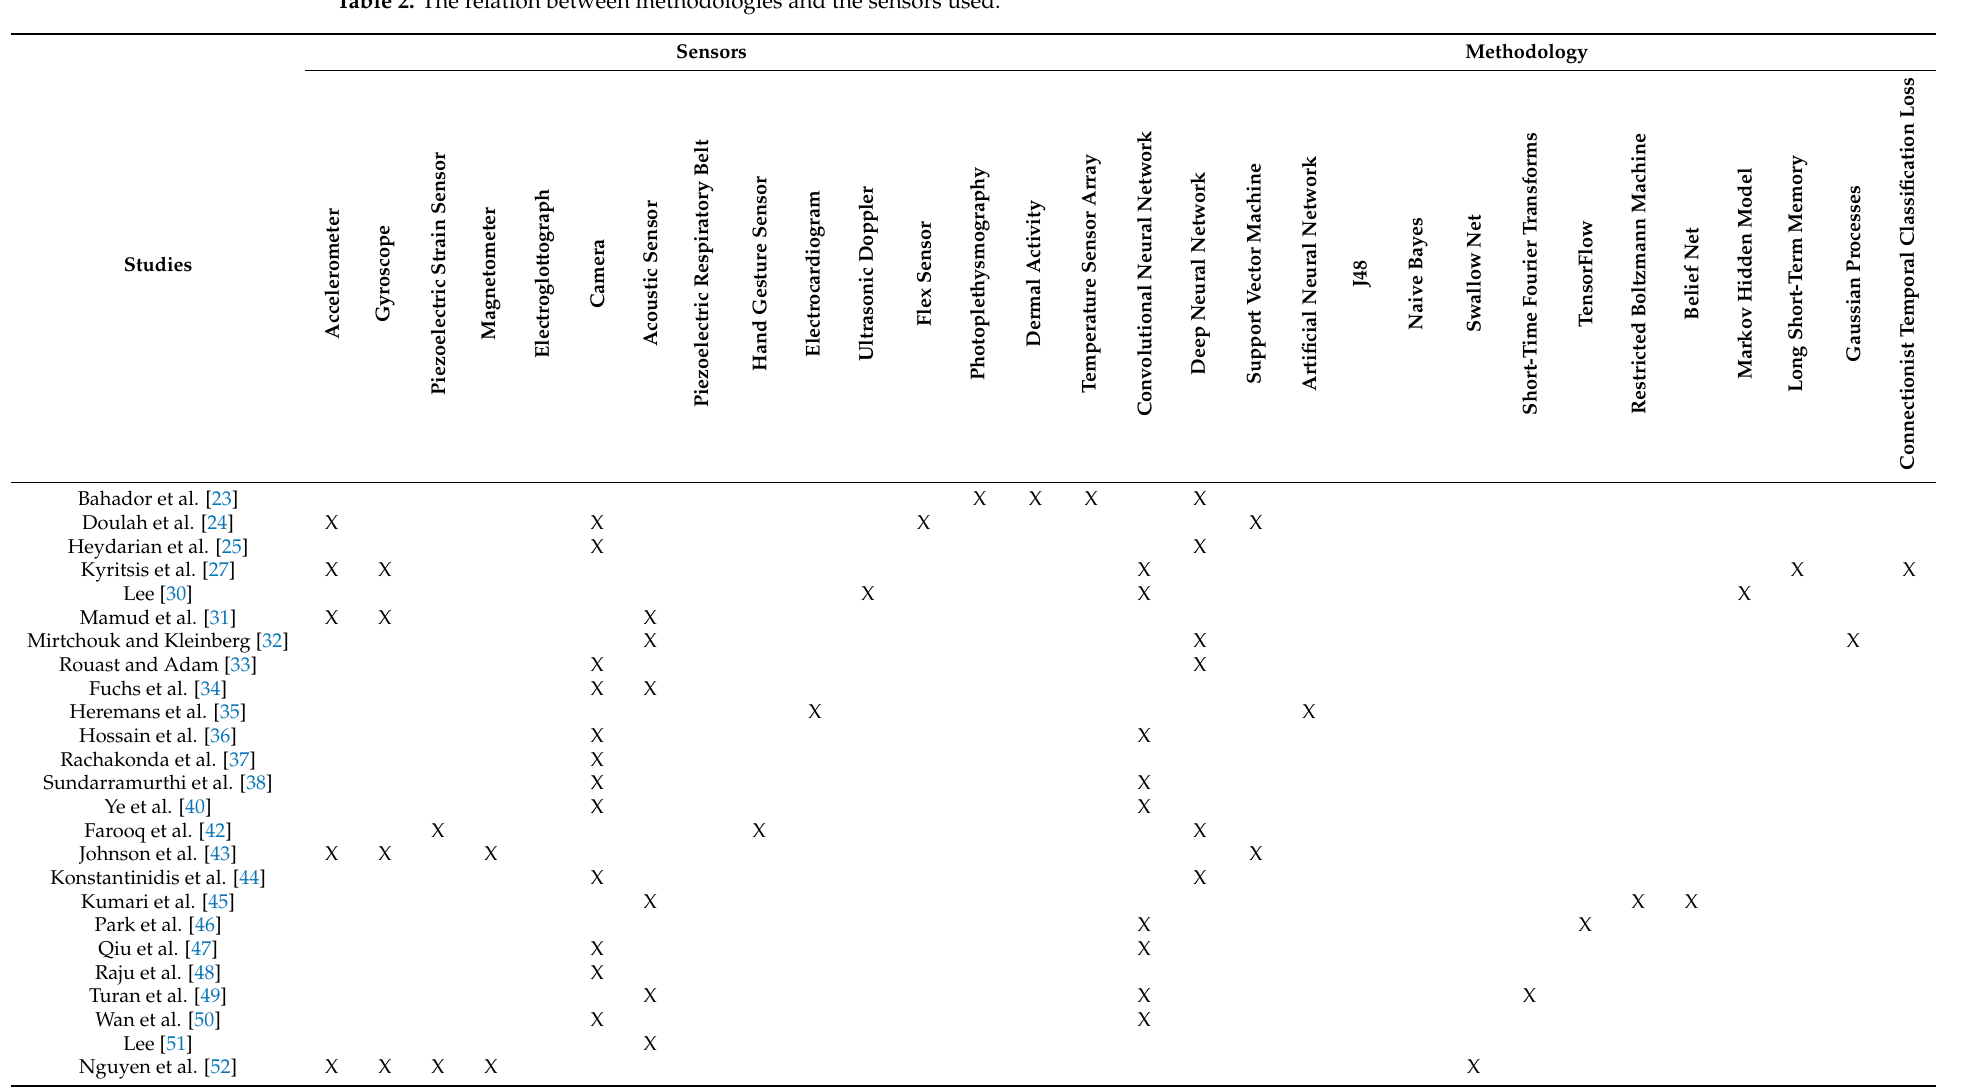
Table 2. The relation between methodologies and the sensors